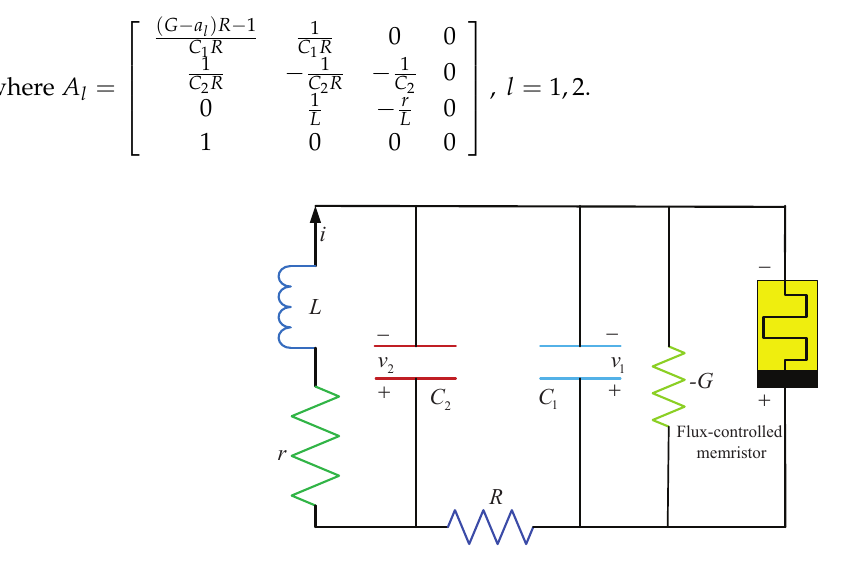
Figure 1. Memristive